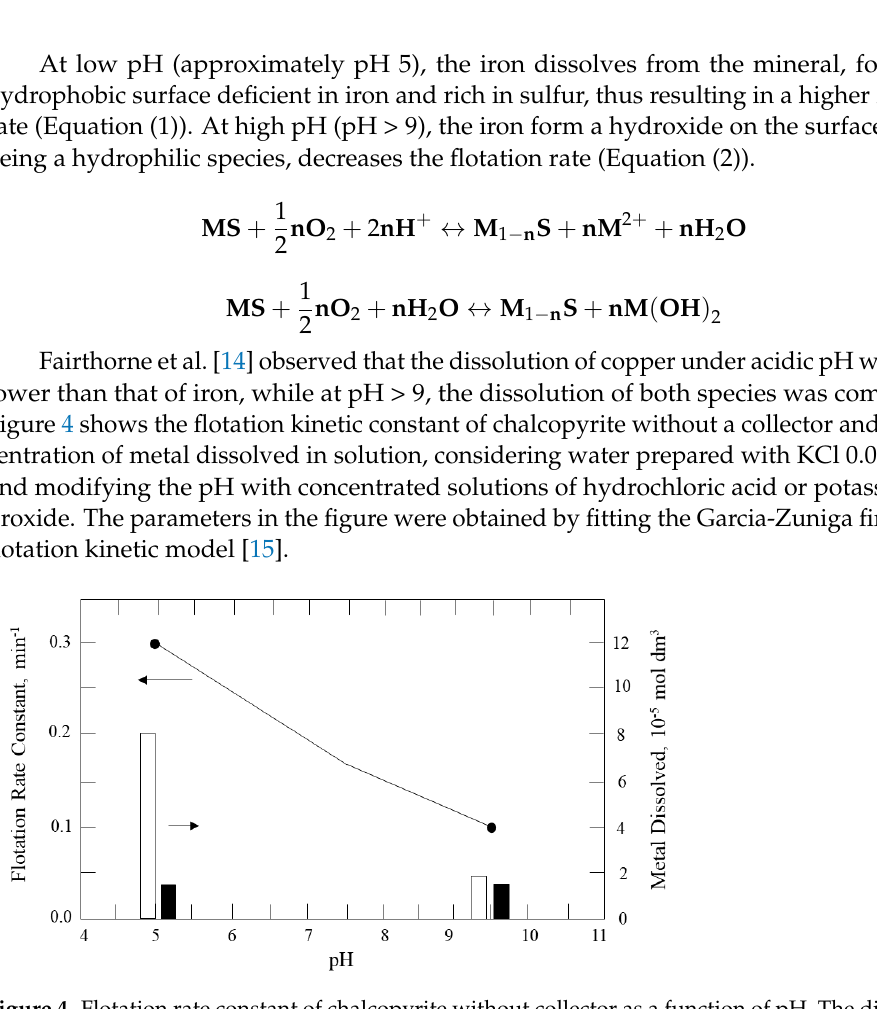
Figure 4. Flotation rate constant of chalcopyrite without collector as a function of pH. The dissolution of iron and copper is represented by the white and black bars, respectively (conditioning with N 2 gas) (adapted from Fairthorne et al. [14]).